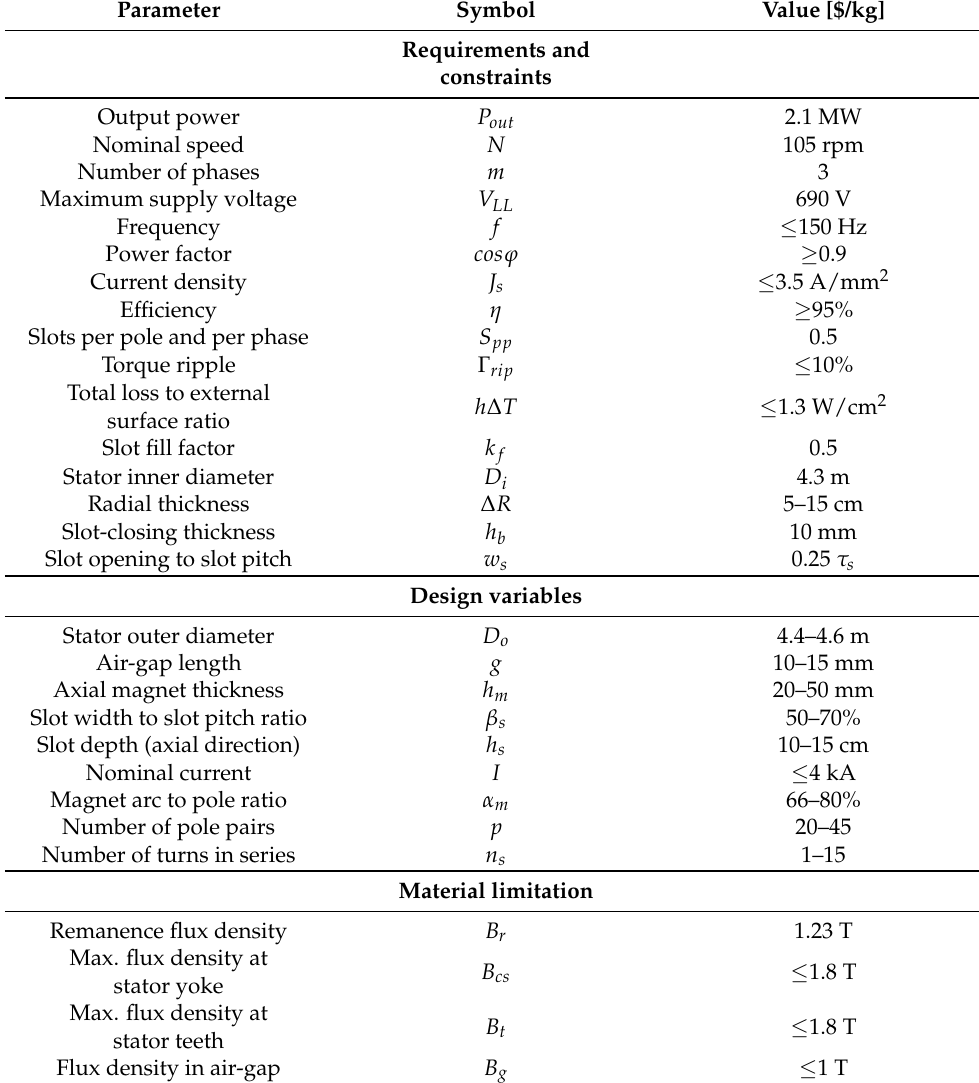
Table 6. Optimization machine constraints and design variable